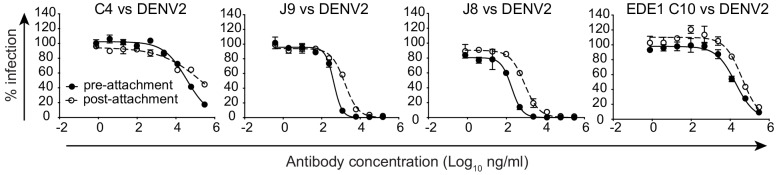
Mechanism of neutralization.Representative dose-response curves for neutralization of DENV2 16681 reporter virus pre- (filled symbols, solid lines) or post-attachment (open symbols, dotted lines) to Raji-DCSIGNR cells by the antibodies indicated above each graph. Results are representative of at least two independent experiments each performed in duplicate. Data points and error bars indicate the mean and range of duplicate wells, respectively.